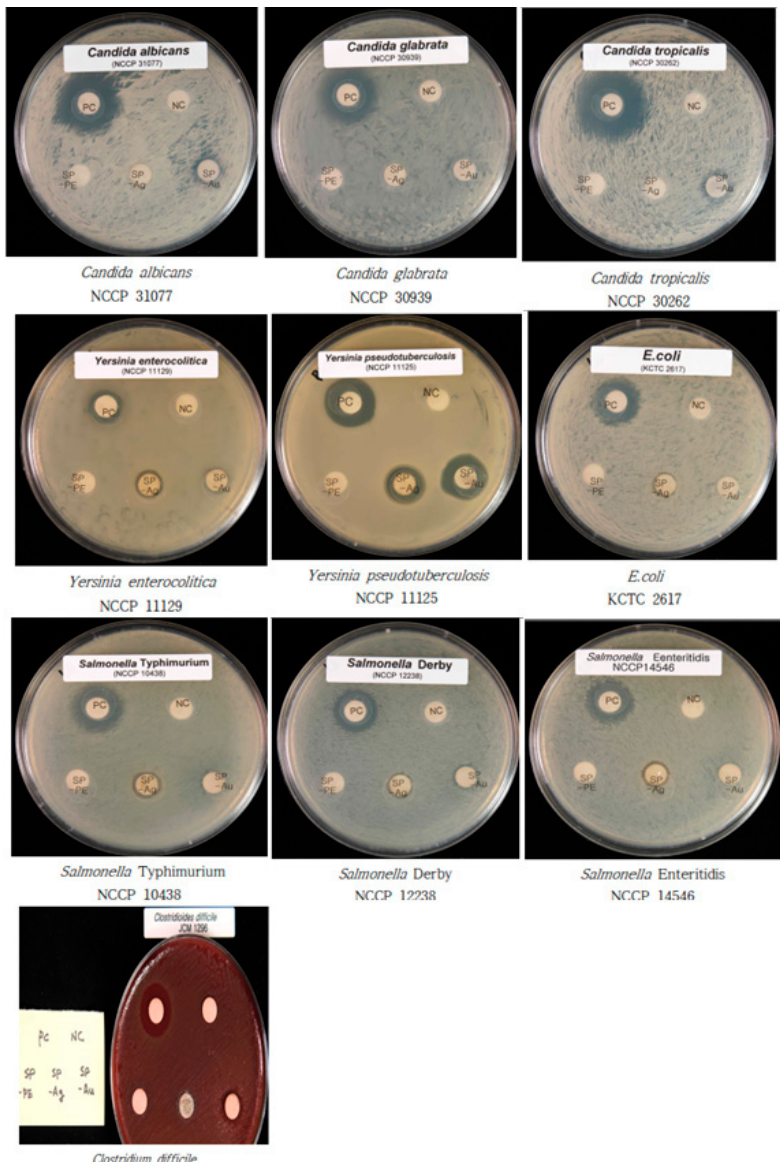
Figure 6. Antibacterial and antifungal activity of biosynthesized SP-AuNPs, SP-AgNPs, and SP extract analyzed using the agar disc diffusion assay. Zone of inhibition was observed and measured against Gram-negative bacterial, Gram-positive bacterial, and fungal livestock pathogenic strains.